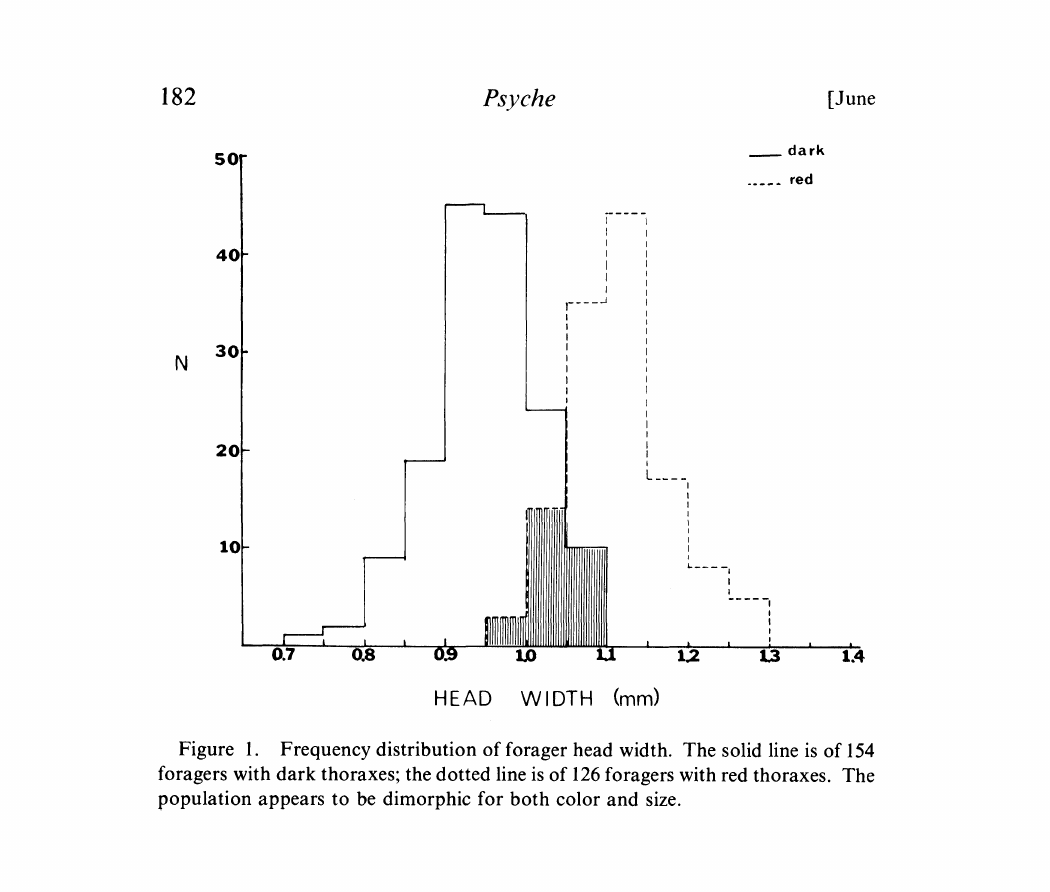
Figure 1. Frequency distribution of forager head width. The solid line is of 154 foragers with dark thoraxes; the dotted line is of 126 foragers with red thoraxes. The population appears to be dimorphic for both color and